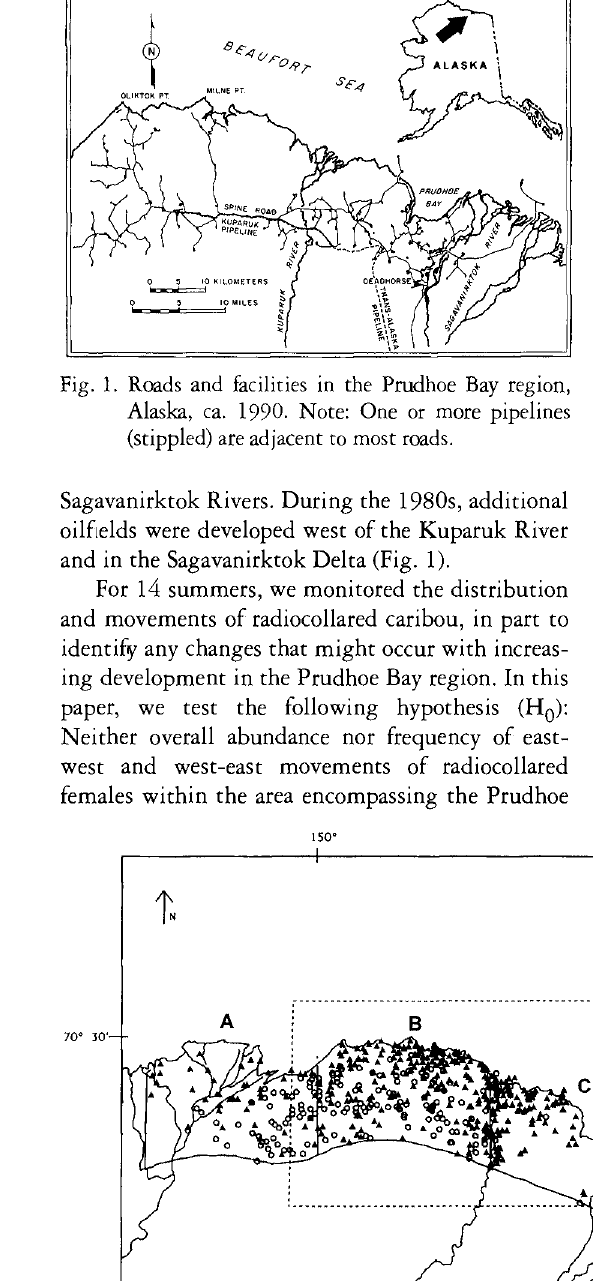
Fig. 2. Locations of radiocollared female caribou within ca. 850-km 2 coastal quadrats in relation to insect activity. Central Arctic Herd, Alaska, summer 1980-1993- Note: Some points represent > 1 female in a single